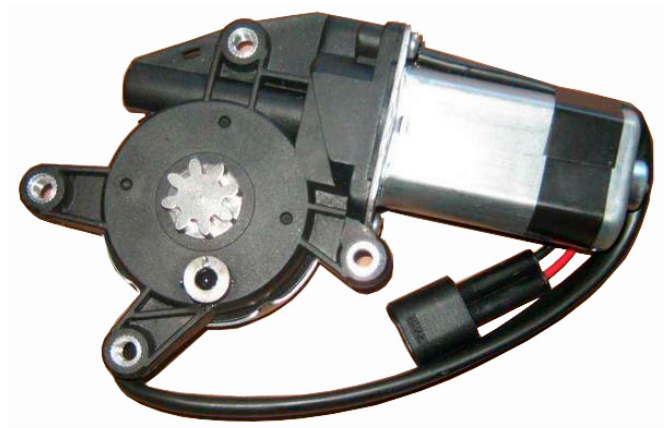
Figure 7. Motor and transmission mechanism. The movement of the experimental glass is driven by the